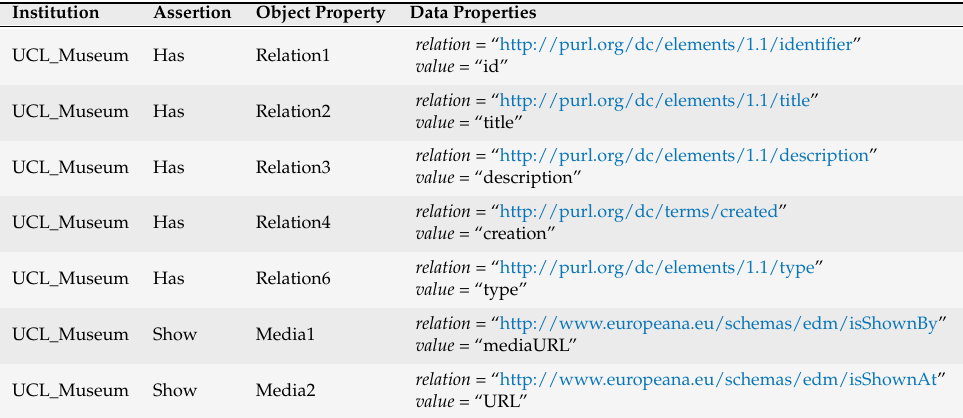
Table 2. Object property assertions of